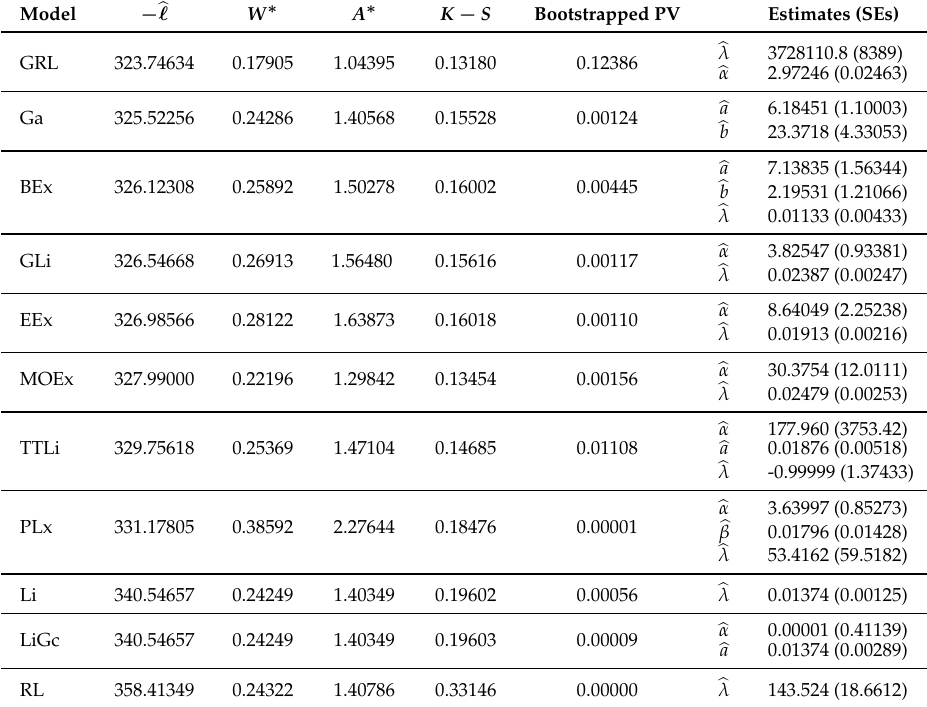
Table 13. Goodness-of-fit statistics, MLEs and SEs, for epicenter data.